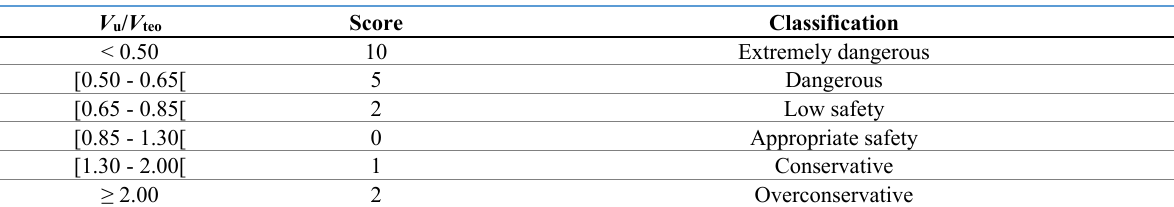
Table 4. Performance of theoretical estimates as proposed by Collins